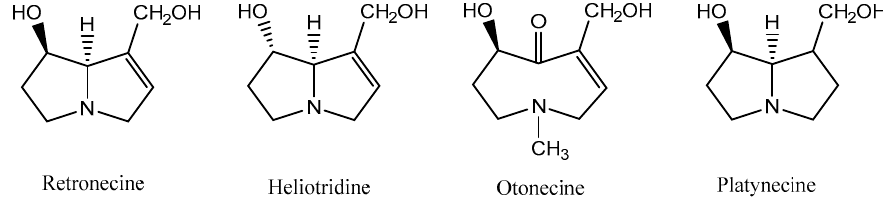
Figure 2. Groups of PA, according to the necine base.